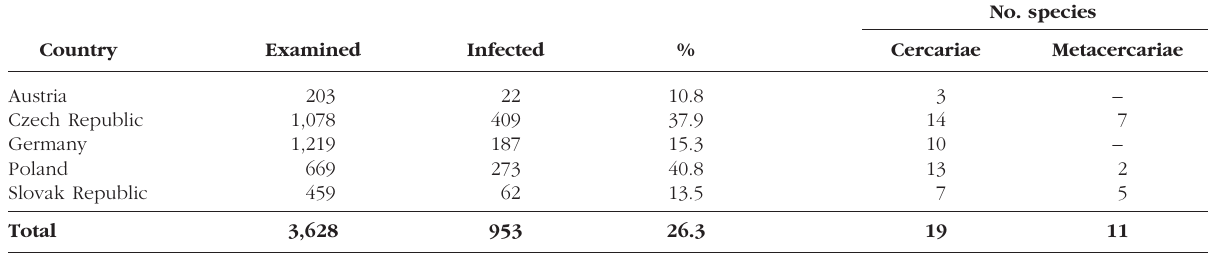
Table I. – Survey of Lymnaea stagnalis